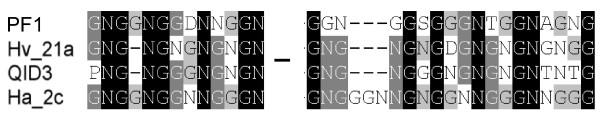
Amino acid alignment of a portion of the extended N-terminus of QID3, Ha_2c, Hv_21a and the Passalora fulva hydrophobin PF1 (for accession number see Table 4). The gap (indicated by a "-") is of different length in the four sequences and therefore not shown. Black background indicates absolutely conserved amino acids. Grey background indicates conservation in at least three of the four proteins.